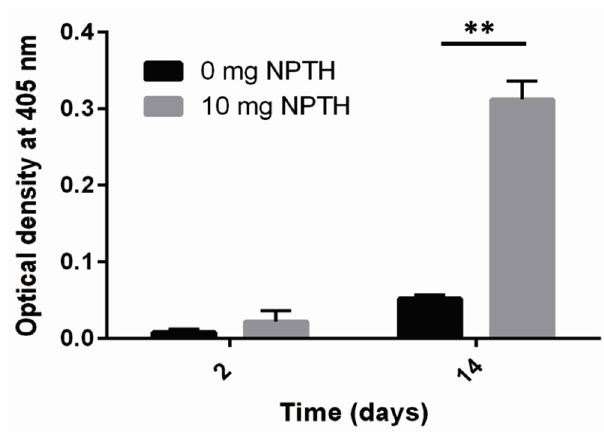
Figure 7. The ALP activity of hFOB cells in response to the treatment of NPTH. Bars represent the optical density at 405 nm and error bars indicate standard deviation, **, p < 0.0001.